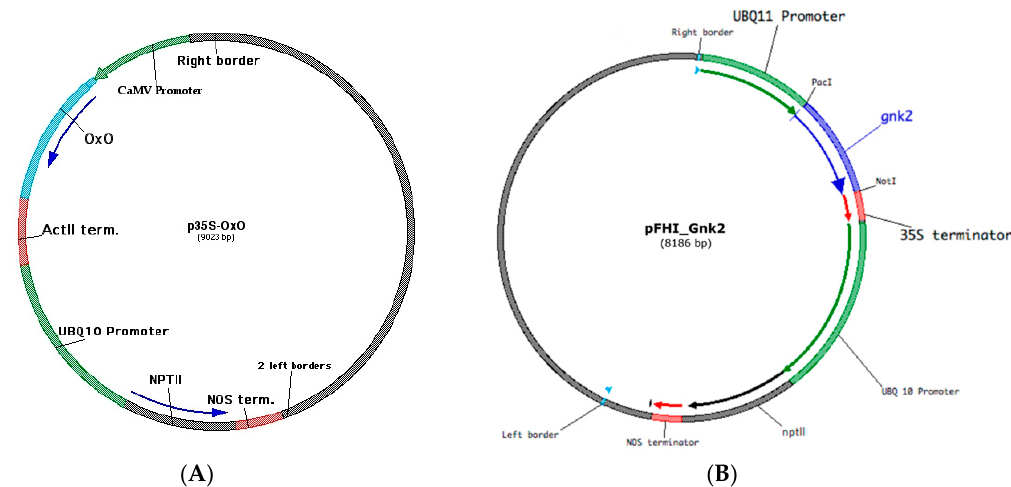
Figure 1. Schematic representation of ( A ) p35S-OxO binary vector showing the orientation and relative positions of the Oxalate Oxidase ( OxO) gene and the neomycin phosphotransferase ( NPTII) selectable marker and their respective regulatory sequences: C auliflower mosaic virus ( CaMV 35S) promoter , Ubiquitin 10 ( UBQ10 ) promoter, Actin2 ( ACT2 ) terminator, and nopaline synthase ( NOS) terminator. ( B ) pFHI_Gnk2 binary vector showing the orientation and relative positions of the potential Phytophthora cinnamomi resistance gene Cast_Gnk2-like (indicated as gnk2 in the scheme) and the NPTII selectable marker and their respective regulatory sequences: Ubiquitin 10 and 11 promoters ( UBQ10 and UBQ11) , respectively; Pac I and Not I restriction sites; CaMV 35S terminator; and NOS terminator.